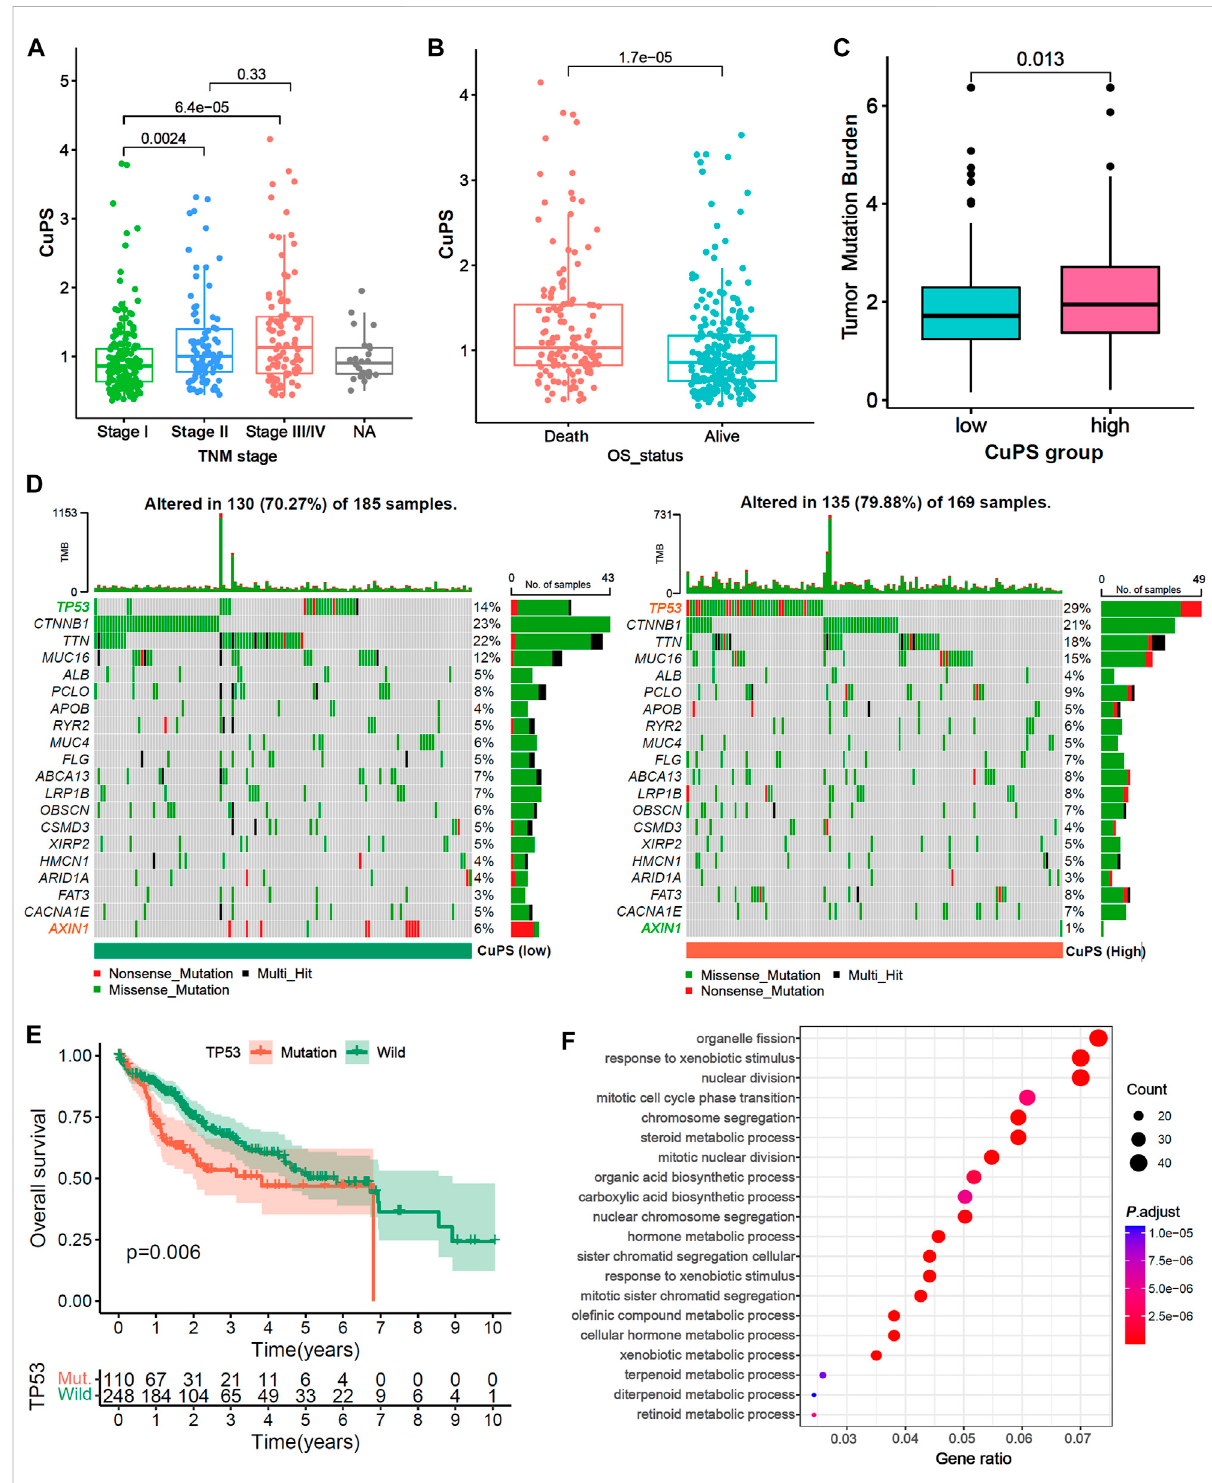
FIGURE 6 Correlation between the Cu-PS and clinical features and the landscape of somatic mutation. (A,B) Comparison of Cu-PS among different TNM stages (A) andsurvivaloutcomes (B) .Differencesinriskscoresbetweendifferentsurvivaloutcome. (C) ComparisonofTMBvaluebetweenhigh-and low- Cu-PS subgroups. (D) The waterfall plots showed the somatic mutation spectrum of the high- and low-risk groups. (E) Kaplan-Meier curves betweenTP53mutation(110patients)andwild(248patients)groupsinTCGA-LIHC. (F) GOenrichmentanalysisoftheDEGsbetweenhigh-and low- Cu-PS